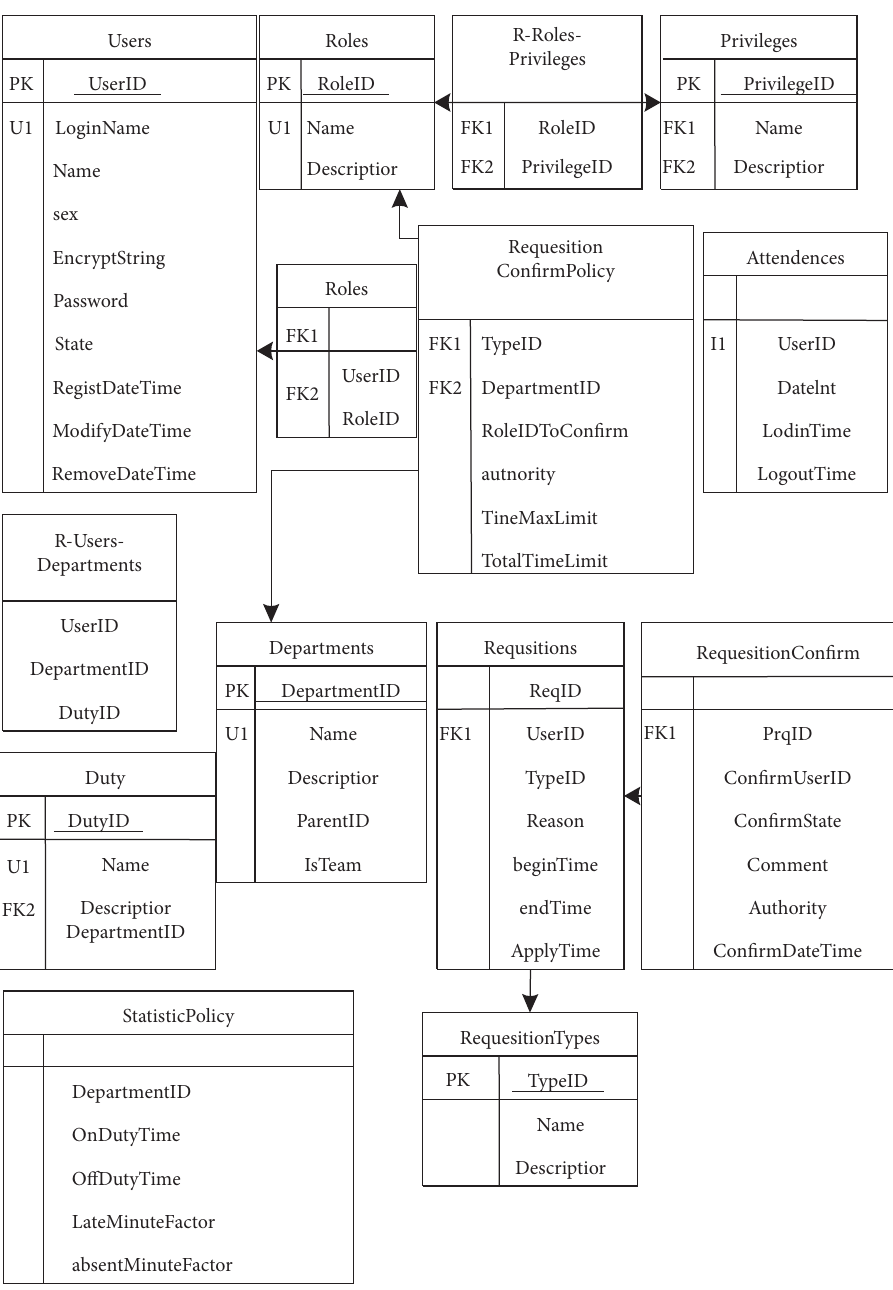
Figure 3: Diagram of platform database